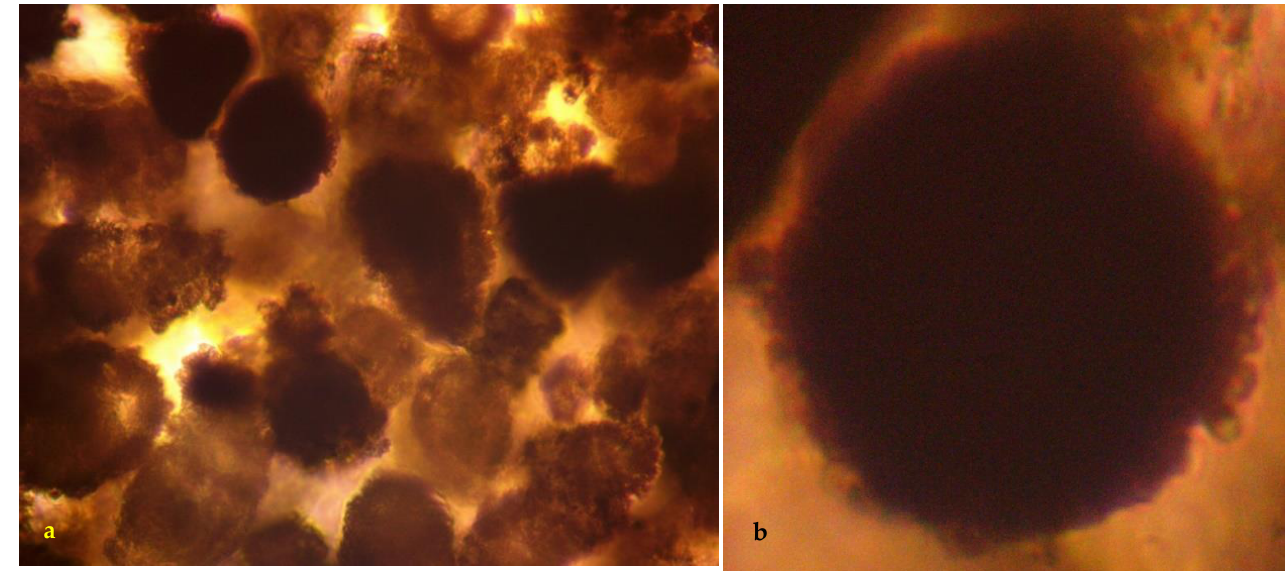
Figure 5. Functionalized n-Fe 0 :Fe(a,b,c) polymer agglomerates: ( a ), Settled agglomerated, hydrated, colloidal nodules produced by n-Fe 0 (50 nm diameter) in saline water after 2000 h. Transmitted light. Field of view = 0.266 mm. Agglomerate size: Average = 0.037 mm; standard deviation = 0.01014; 1st quartile = 0.027 mm; median = 0.0377 mm; 3rd quartile = 0.044 mm; ( b ) agglomerated colloidal, hy- drated nodule produced by n-Fe 0 (50 nm diameter) in saline water (after 2000 h). Nodule size = 0.0498 mm × 0.0459 mm. The nodule grows by the accretion of hydrated colloidal spheres (about 0.003 mm in diameter) around its periphery. Transmitted light. Field of view = 0.05 mm.